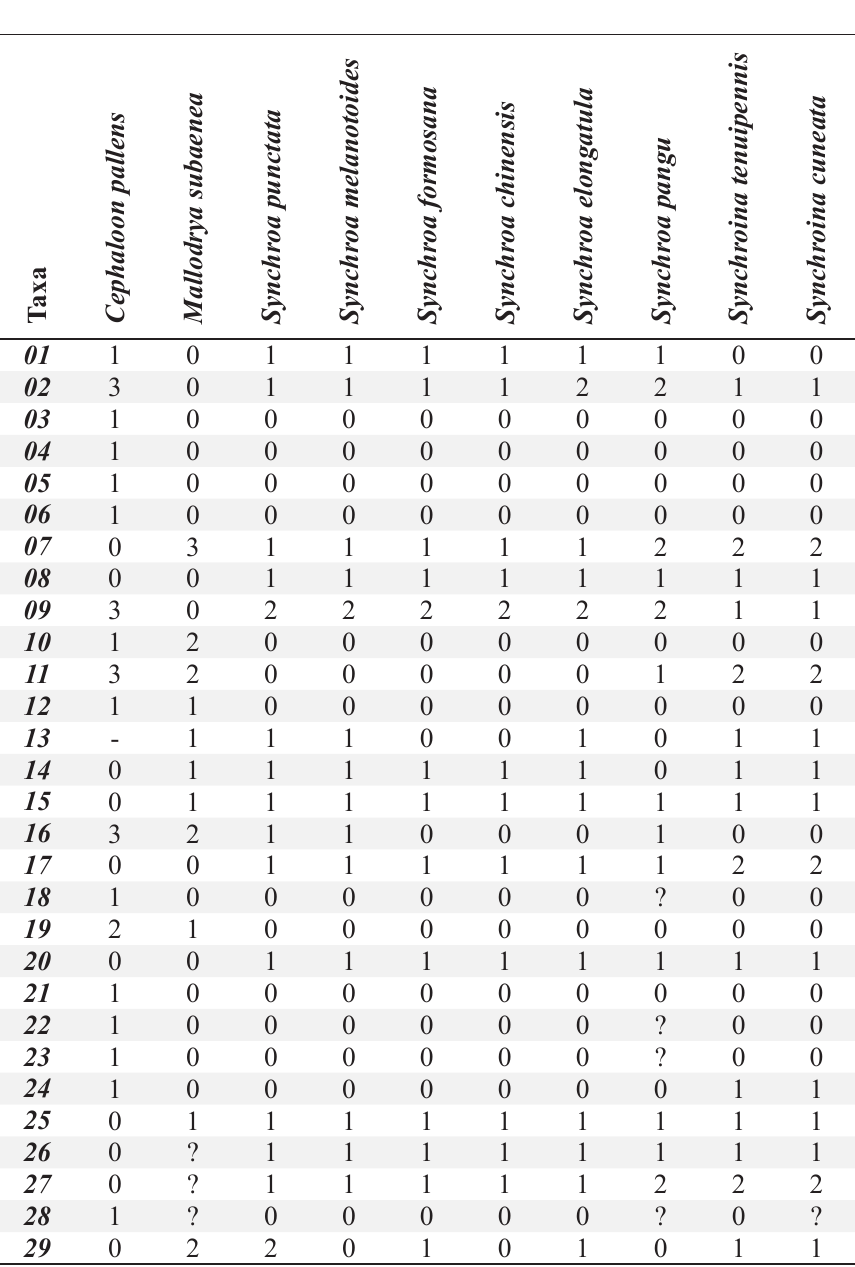
Table 1. Data matrix.